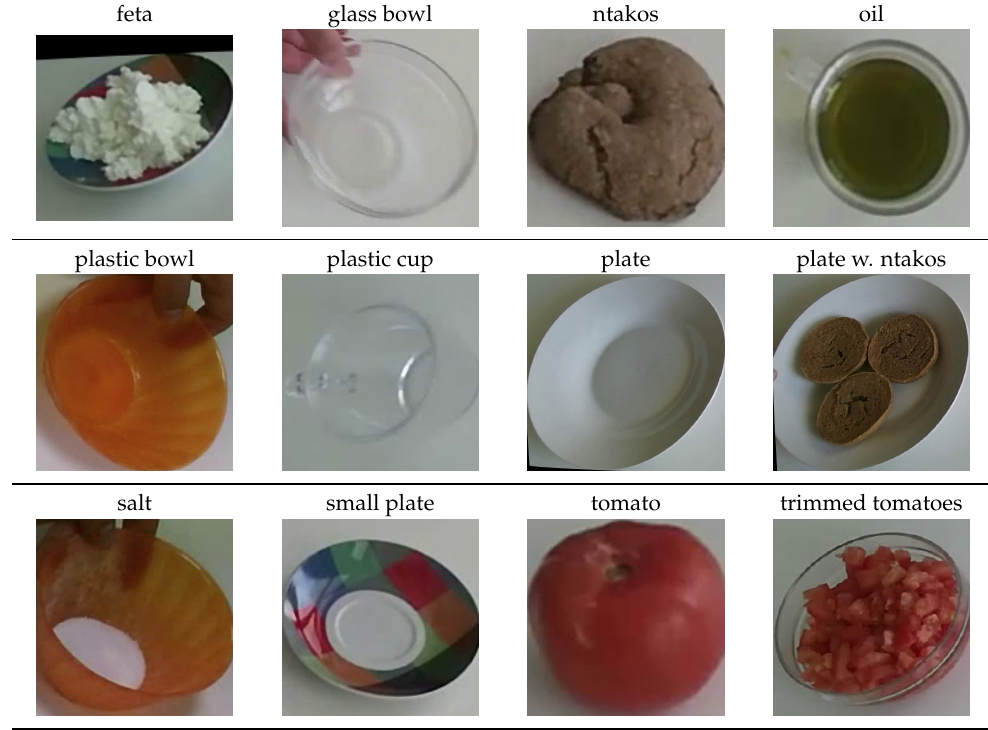
Table 2. Indicative images from the dataset for “Greek Ntakos” recipe.